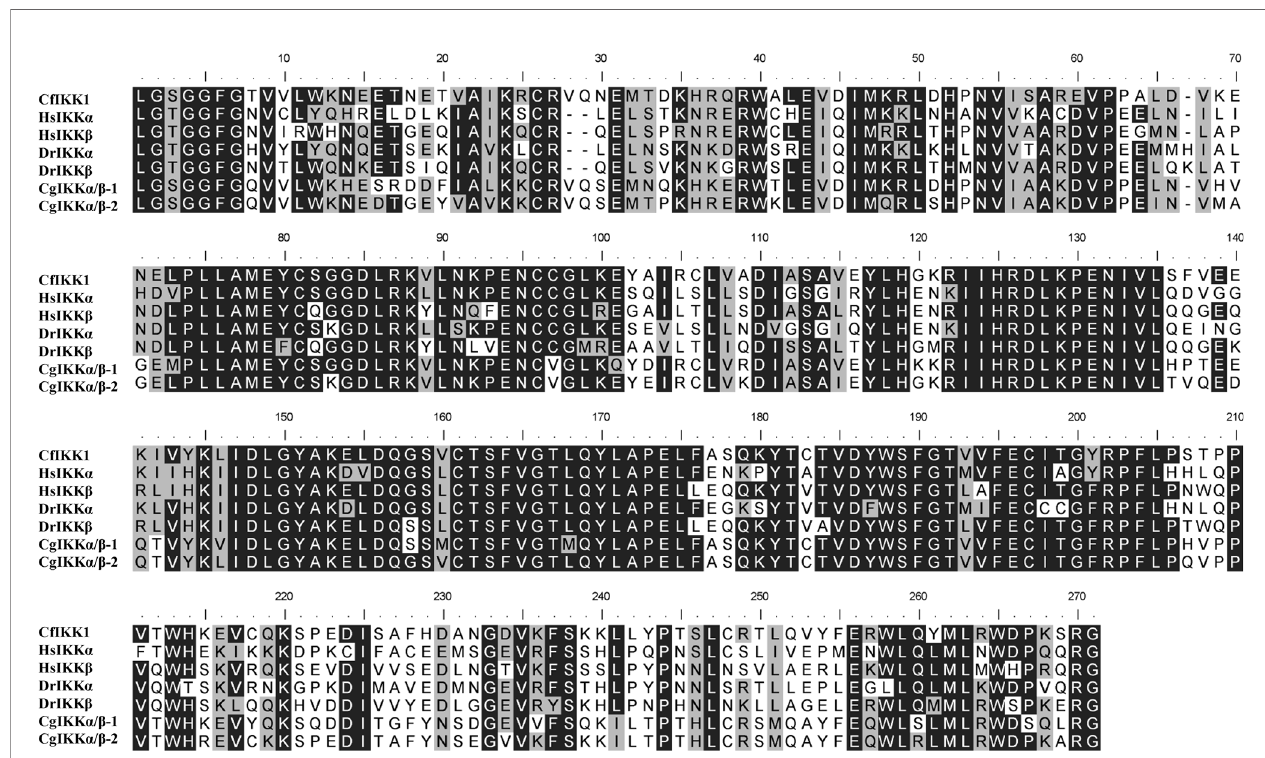
FIGURE 3 | Multiple sequence alignment of the kinase domain of canonical IKK proteins from different species. Sequences with identical amino acids are shaded in black, whereas conservative amino acid substitutions are shaded in gray. The GenBank accession numbers for the sequences used are as follows: HsIKK a , NP_001269.3; HsIKK b , NP_001547.1; DrIKK a , NP_956611.1; DrIKK b , NP_001116737.1; CgIKK a / b -1, NP_001295815.1; CgIKK a / b -2, XP_011449001.1. Cf, Chlamys farreri ; Hs, Homo sapiens ; Dr, Danio rerio ; Cg, Crassostrea gigas